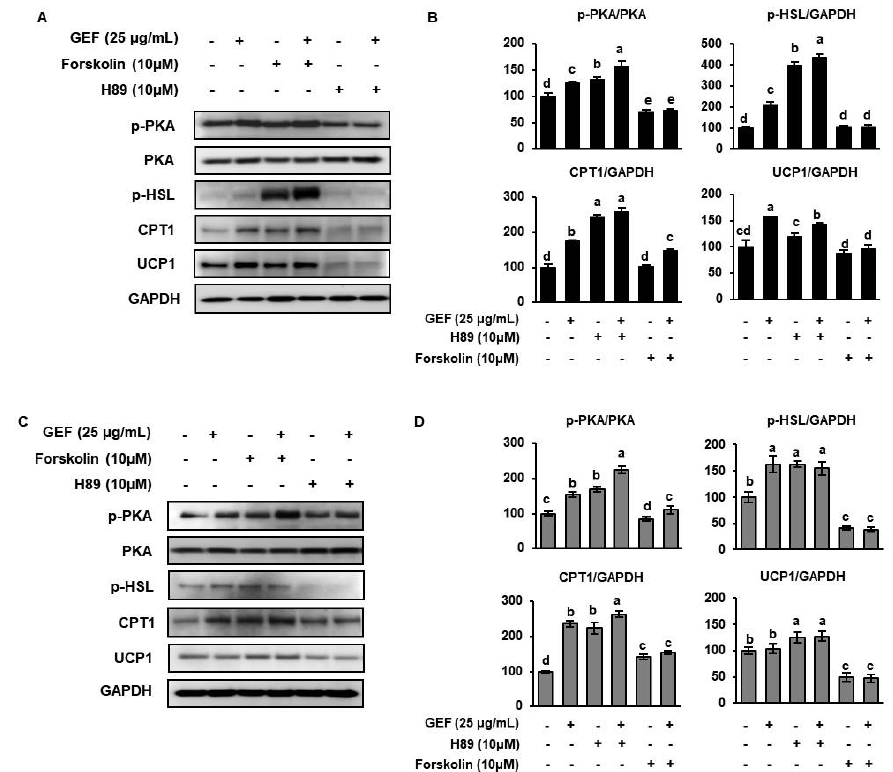
Figure 6. E ff ects of PKA activation and inhibition in 3T3-L1s and SATs treated with GEF. ( A , B ) 3T3-L1s Figure 6. Effects of PKA activation and inhibition in 3T3-L1s and SATs treated with GEF. ( A–B ) 3T3- were treated with 10 µ M forskolin or 10 µ M H89 ± 25 µ M GEF, and the e ff ects on protein phosphorylation L1s were treated with 10 µM forskolin or 10 µM H89 ± 25 µM GEF, and the effects on protein and / orexpressionweredeterminedbyWesternblotting. ( C , D )SATsweretreatedwith10 µ MCC ± 25 µ M phosphorylation and/or expression were determined by Western blotting. ( C–D ) SATs were treated GEF, and the e ff ects on protein phosphorylation and / or expression were determined by Western blotting. with 10 µM CC ± 25 µM GEF, and the effects on protein phosphorylation and/or expression were Data are expressed as mean ± SD ( n = 4). Treatments with di ff erent letters were significantly di ff erent, determined by Western blotting. Data are expressed as mean ± SD (n = 4). Treatments with different p < 0.05 (a > b > c > d). Forskolin is 7 β -Acetoxy-8,13-epoxy-1 α ,6 β ,9 α letters were significantly different, p < 0.05 (a > b > c > d). Forskolin is 7β-Acetoxy-8,13-epoxy-1α,6β,9α- trihydroxylabd-14-en-11-one, and H89 is N-[2-(p-Bromocinnamylamino)ethyl]-5- isoquinolinesulfonamide dihydrochloride.